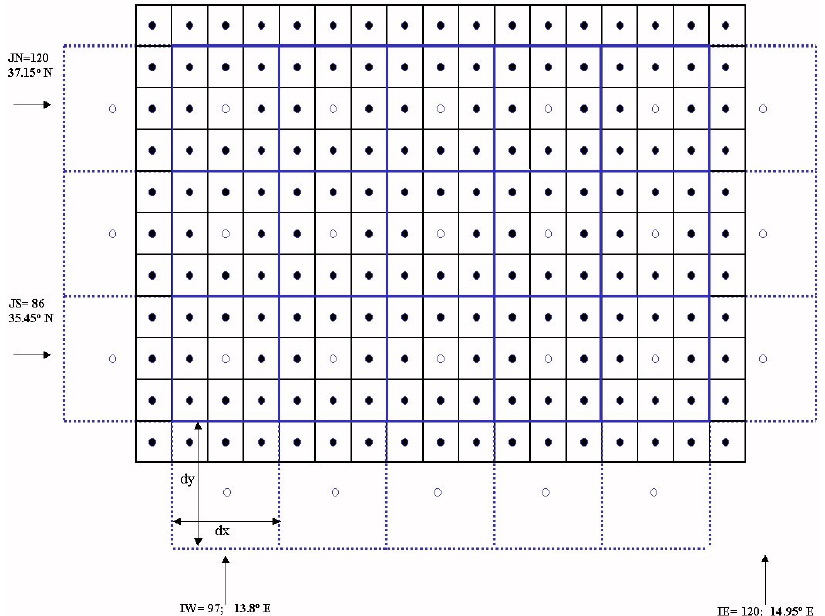
Fig. 4. Details of the coupling be- tween the embedded shelf model fine grid ( • ) and the coarser intermediate model grid ( ◦